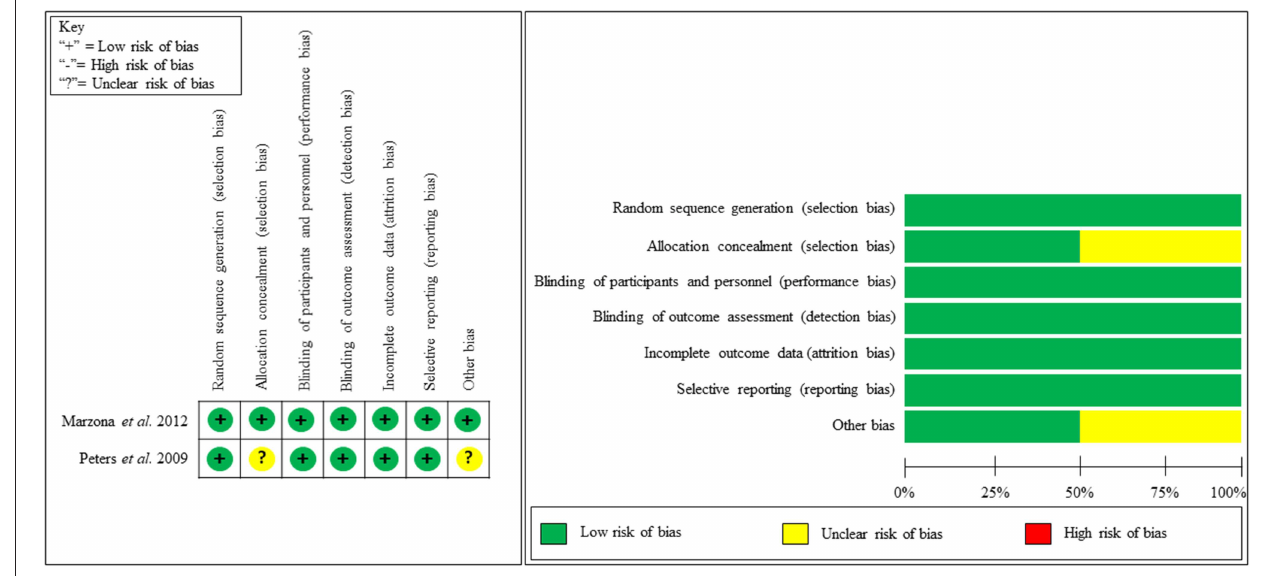
FIGURE 2 | Methodological quality assessment of